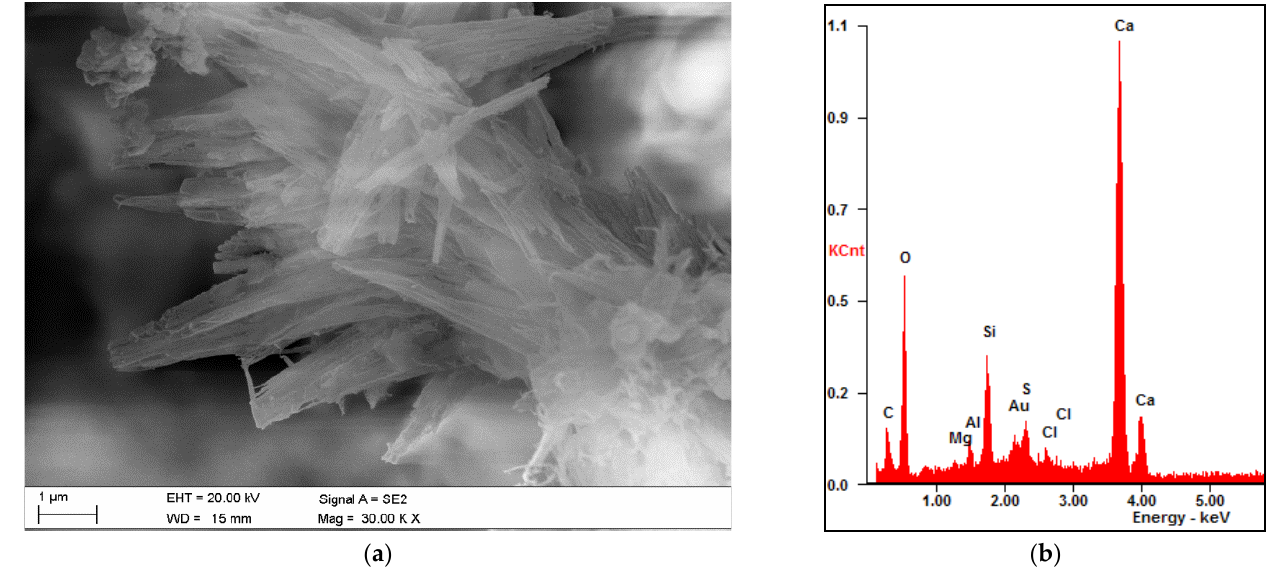
Figure 8. Solid solution of ettringite with thaumasite in B-4 specimen at a depth of 2.2 mm: ( a ) SEM image; ( b ) Chemical composition.